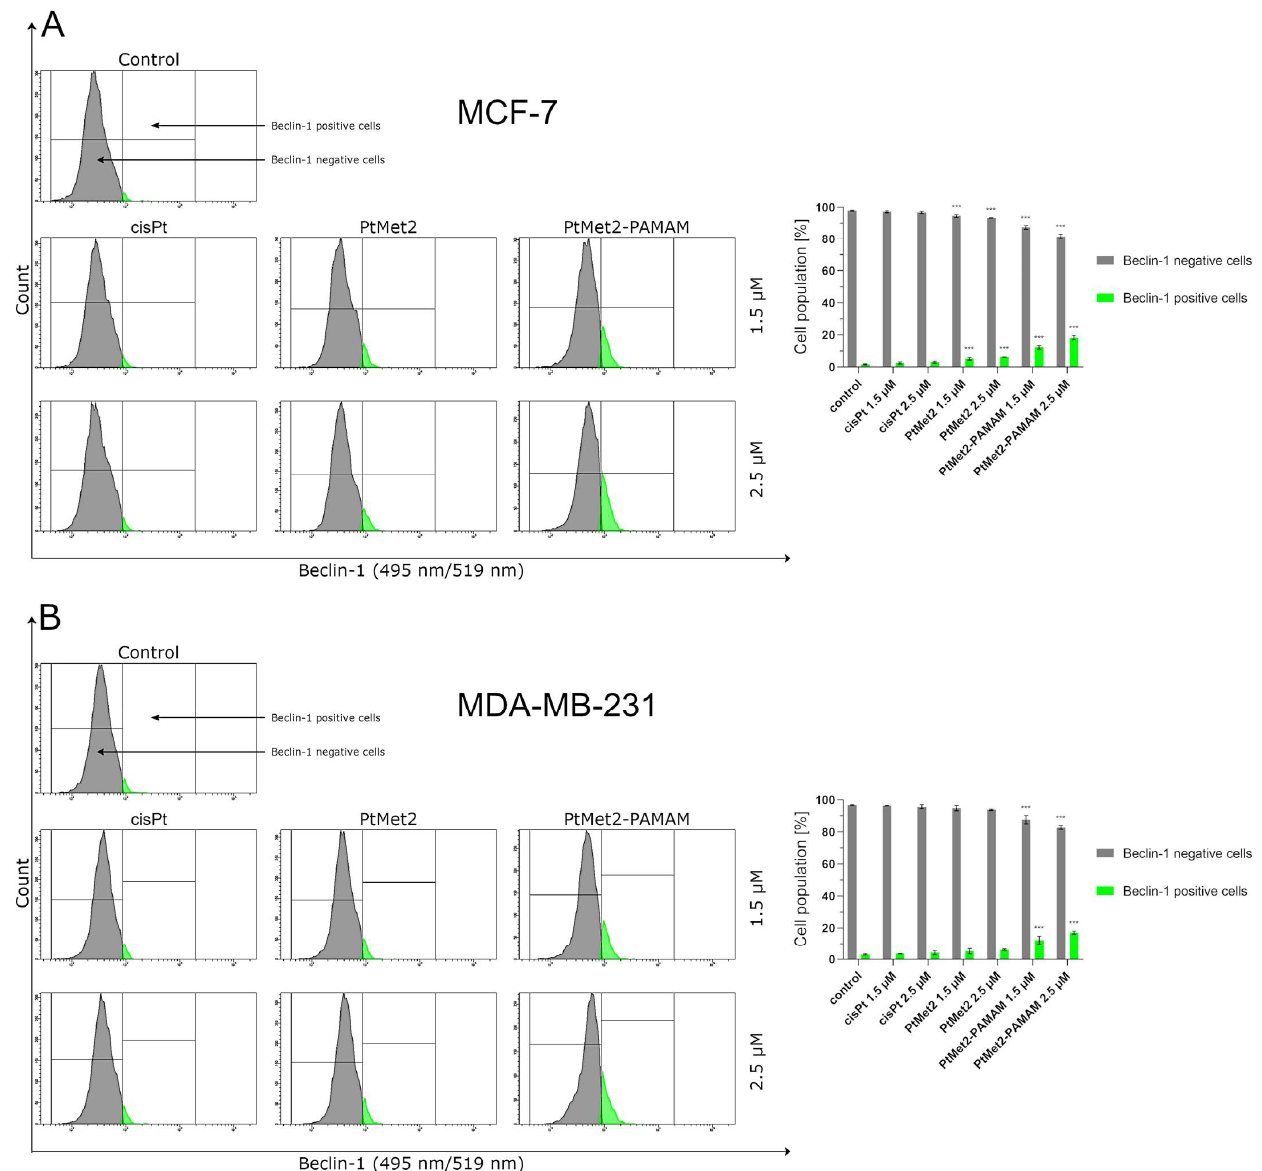
Figure 13. Anti-Beclin-1 antibody flow cytometric analysis of MCF-7 ( A ) and MDA-MB-231 breast cancer cells ( B ) (light green color) compared to a negative control cell (gray color) after 24 h of incubation with PtMet2, PtMet2–PAMAM, and cisplatin (1.5 μM and 2.5 μM). Mean percentage values from three independent experiments ( n = 3) done in duplicate are presented. *** p < 0.001 vs. control group.